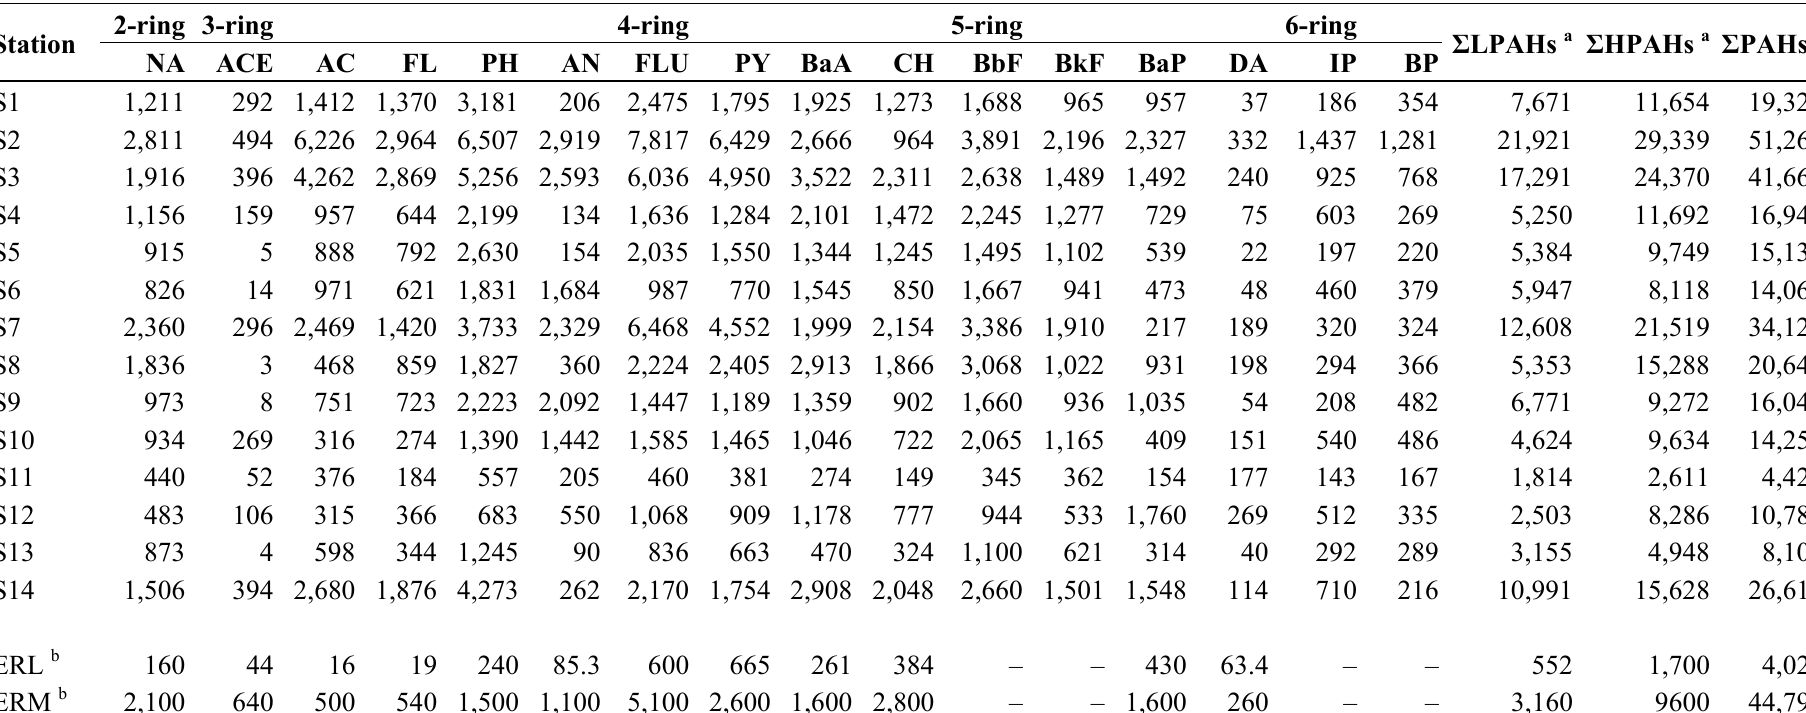
Table 4. PAH concentration (ng/g dw) in surfaces sediments of industrial port area of southern Kaohsiung